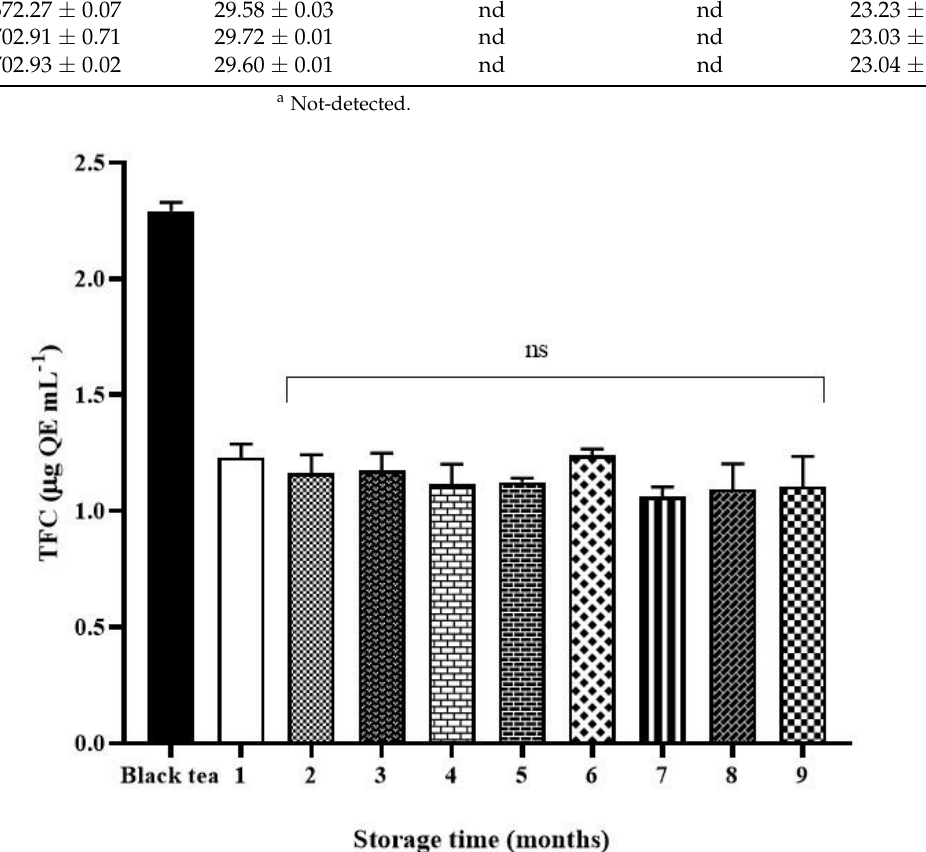
Figure 5. Total flavonoid content (TFC) ( µ g QE mL − 1 ) of black tea, kombucha tea after 30 days of fermentation and all the samples over storage. Black bar refers to the starting tea. White bar refers to the kombucha sample after 30 days of fermentation (control).